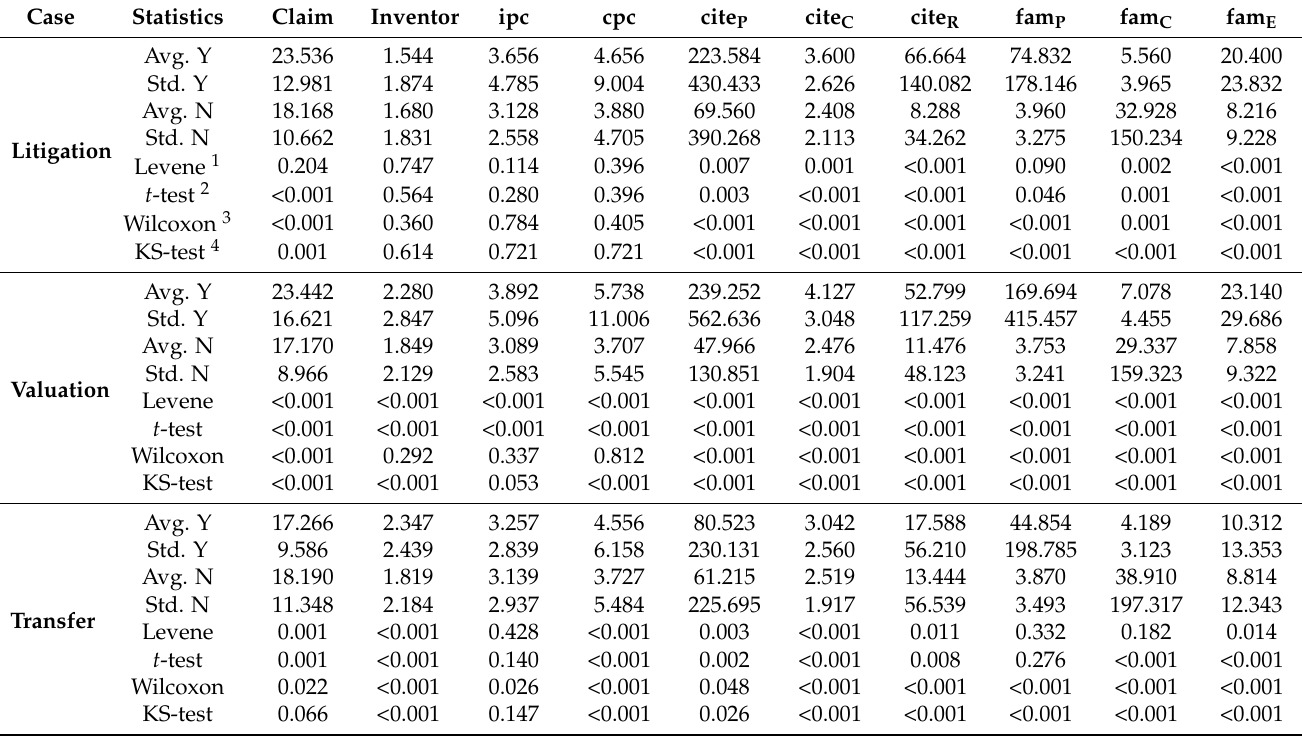
Table 2. Results of statistical test for Hypothesis 1.